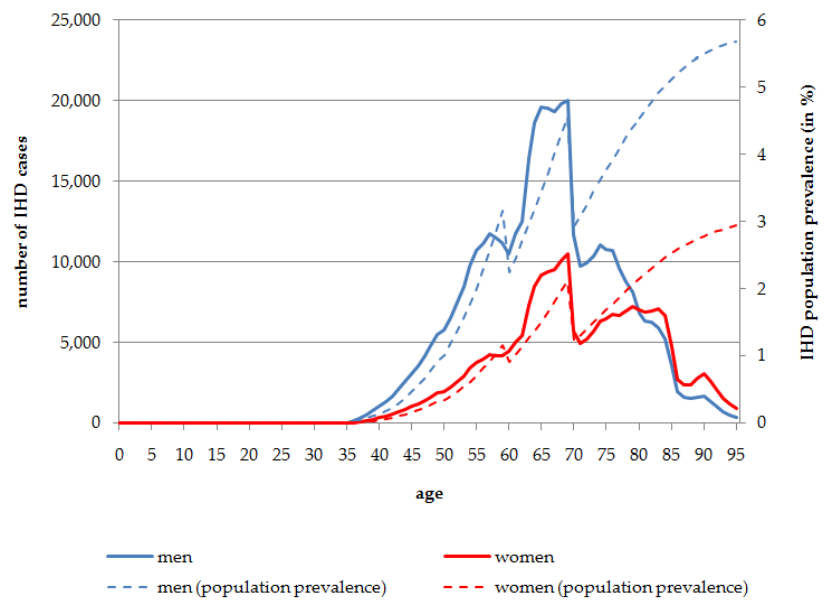
Figure 1. Number of persons affected by IHD attributable to SHS exposure, stratified by age and sex, Germany, 2014.